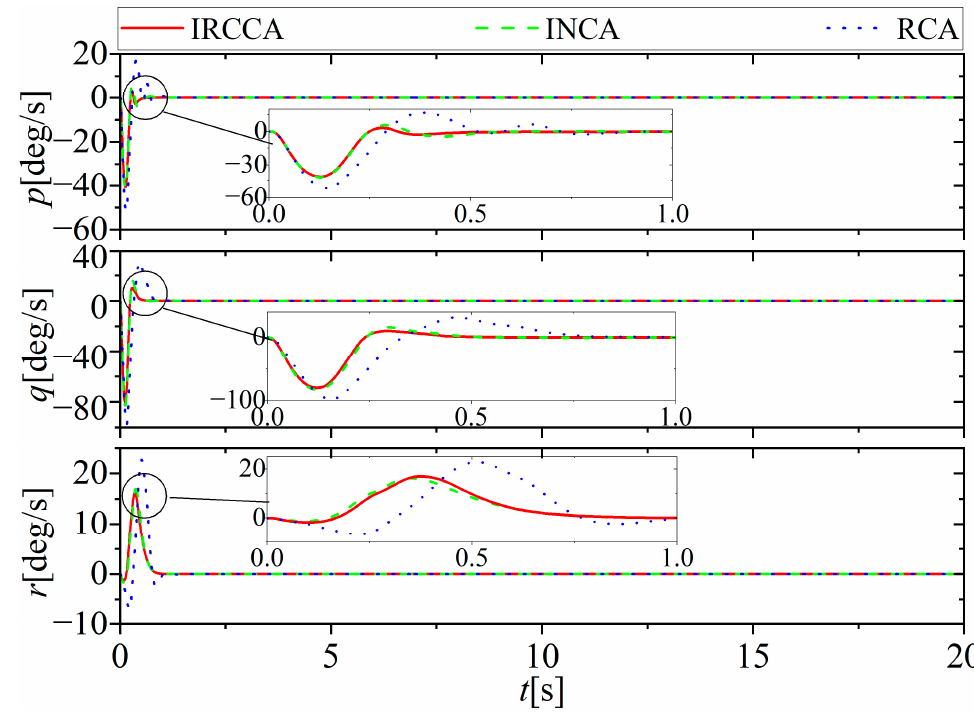
Figure 3. Time response of the attitude angle rate with no actuator fault.